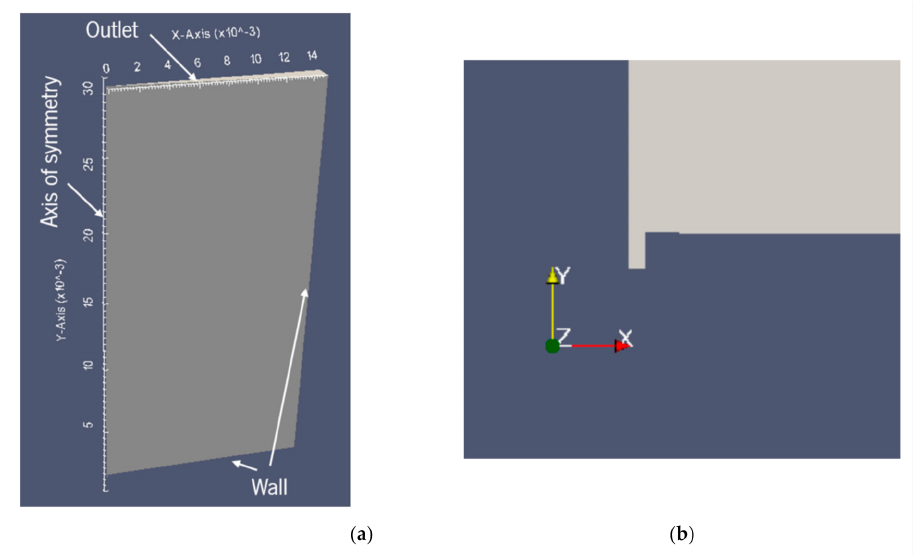
Figure 4. Geometry definition of the computational domain. ( a ) General geometry definition. ( b ) Nucleation cavity